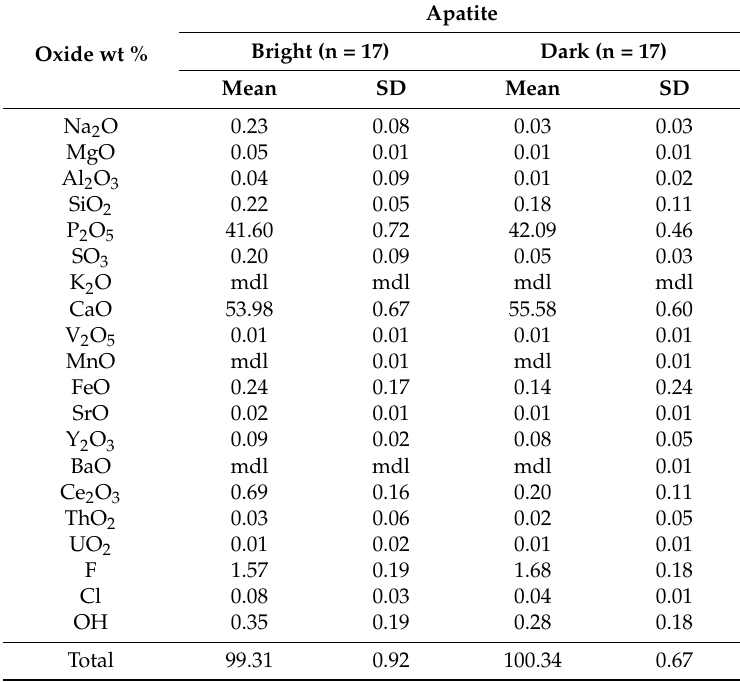
Table 3. EPMA data (wt %) for bright and dark apatites from Chadormalu MAA-marginal ore apatite type.